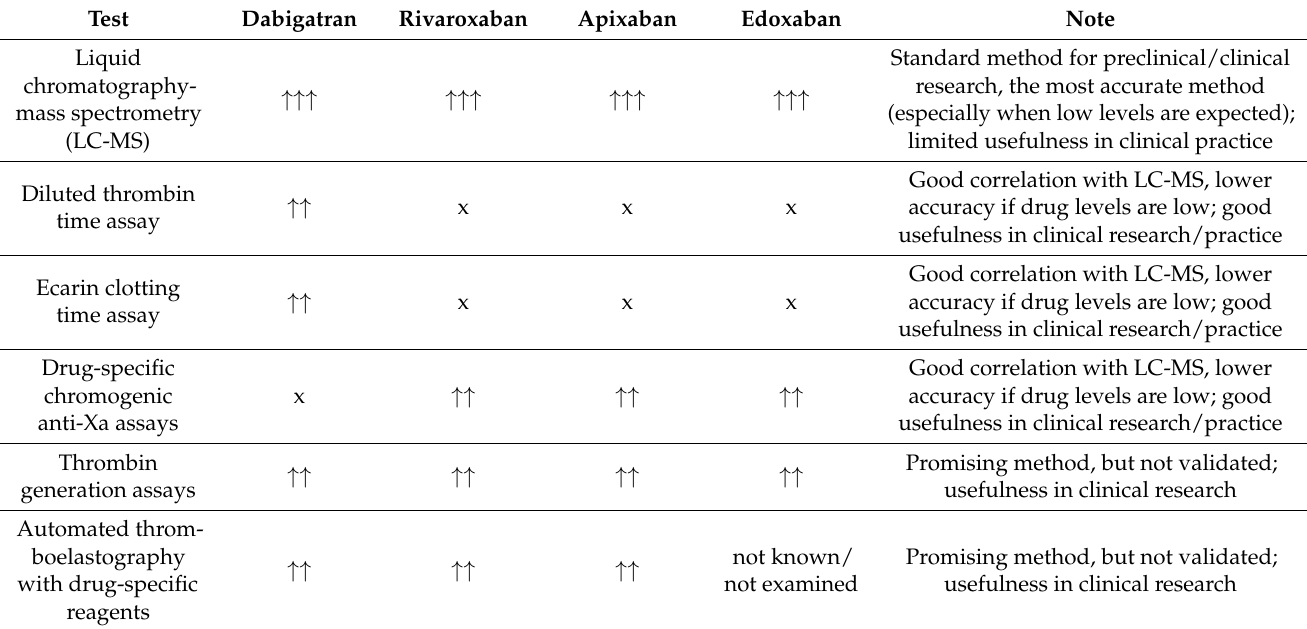
Table 2. Specific assays for determination of DOAC